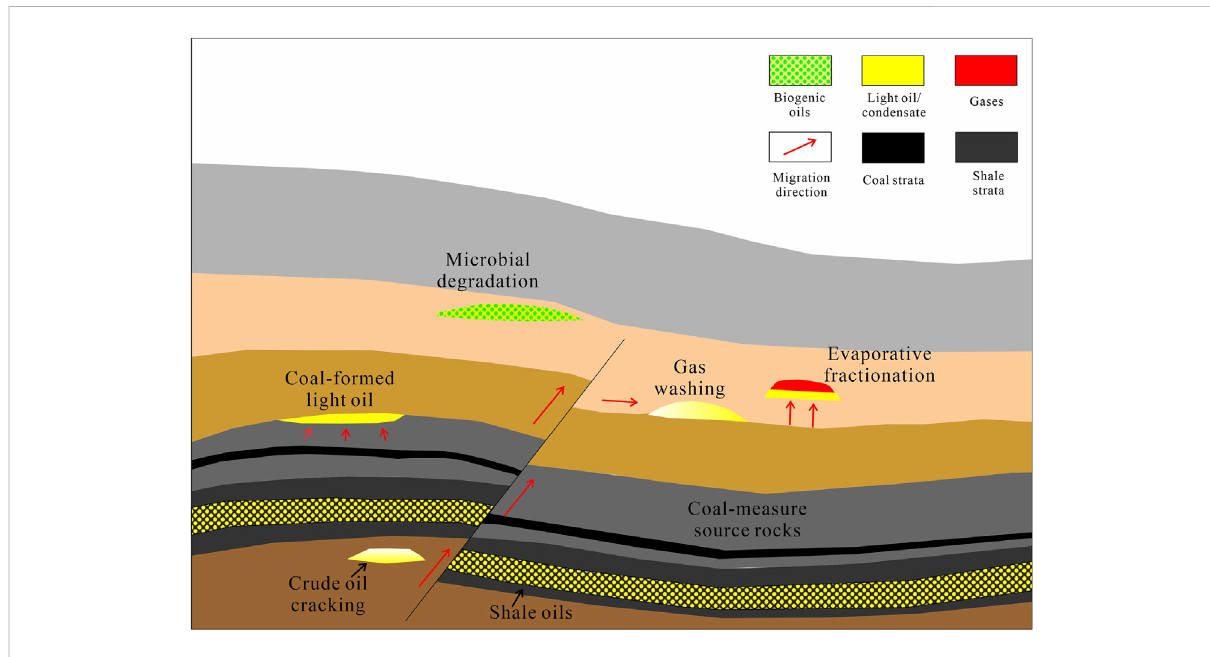
FIGURE 1 Schematic map showing various sources and genesis mechanisms of light